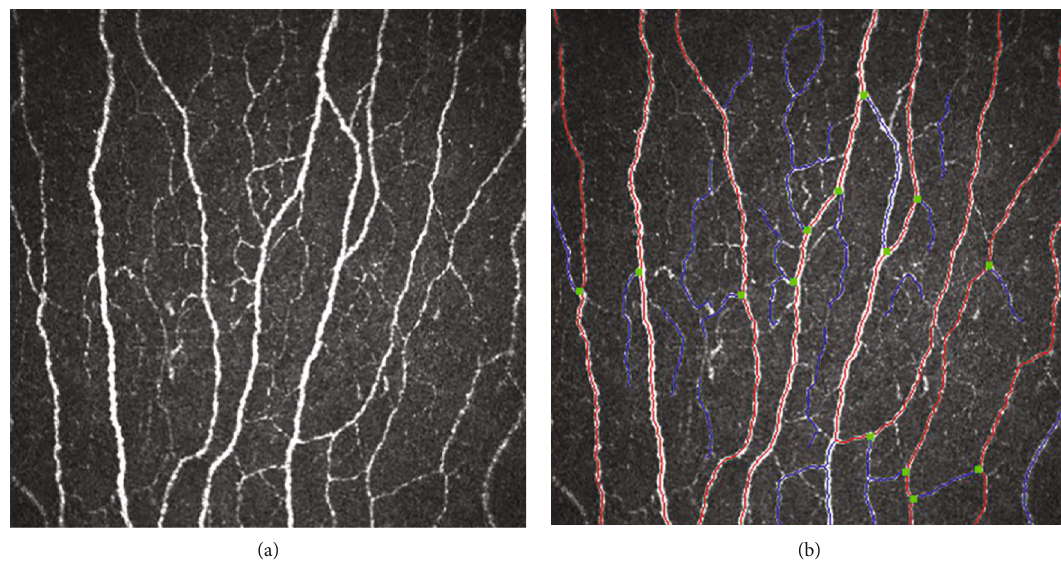
Figure 1: A representative in vitro corneal confocal microscopy image and the corresponding analyzed image in a healthy participant. (a) A representative in vitro corneal confocal microscopy image of a healthy participant ’ s central corneal subbasal nerve plexus. (b) The corresponding nerve fi ber image analyzed by the automated software (ACCMetrics, University of Manchester, Manchester, UK). Red lines indicate the main corneal nerve fi bers, corneal nerve branches are represented in blue, and branch points are shown in green